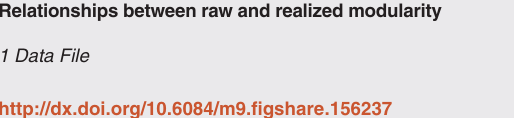
is not affected by connectance, allowing to use it to compare R